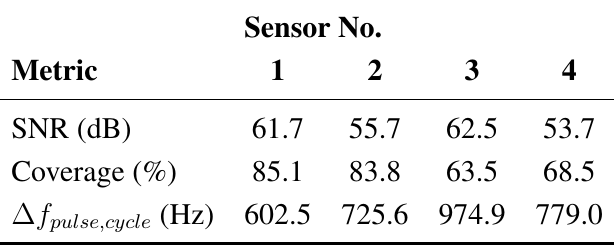
Figure 10. Bland–Altman plot of the beat-to-beat intervals, BB the MAIN Shirt and the reference sensor, respectively, during apnea. ( a ) Non-smoothed values obtained from the raw signal; ( b ) values smoothed by a sliding average of five elements.